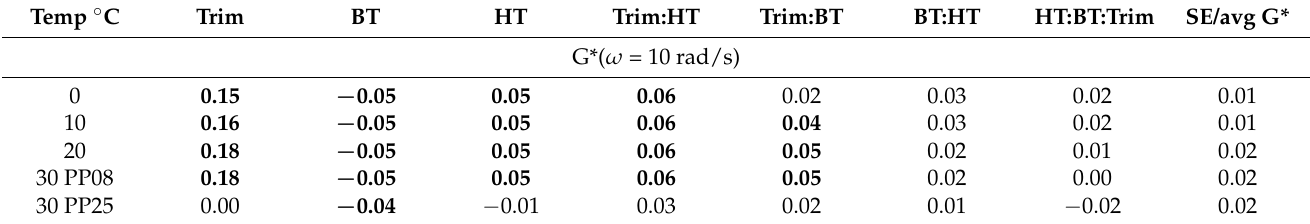
Table 9. Effect estimates and Standard Errors (SE) for 160/220_II. The significant effects with a 95% confidence interval are shown in